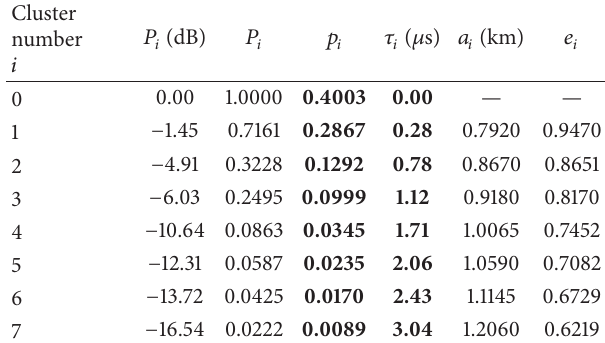
Table 1: Parameters for individual clusters ( 𝑁 = 7 ).